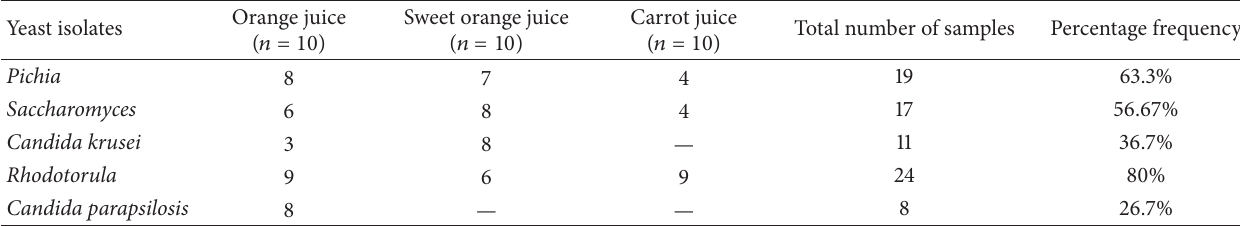
Table 9: Percentage abundance of yeast isolates in juice samples.